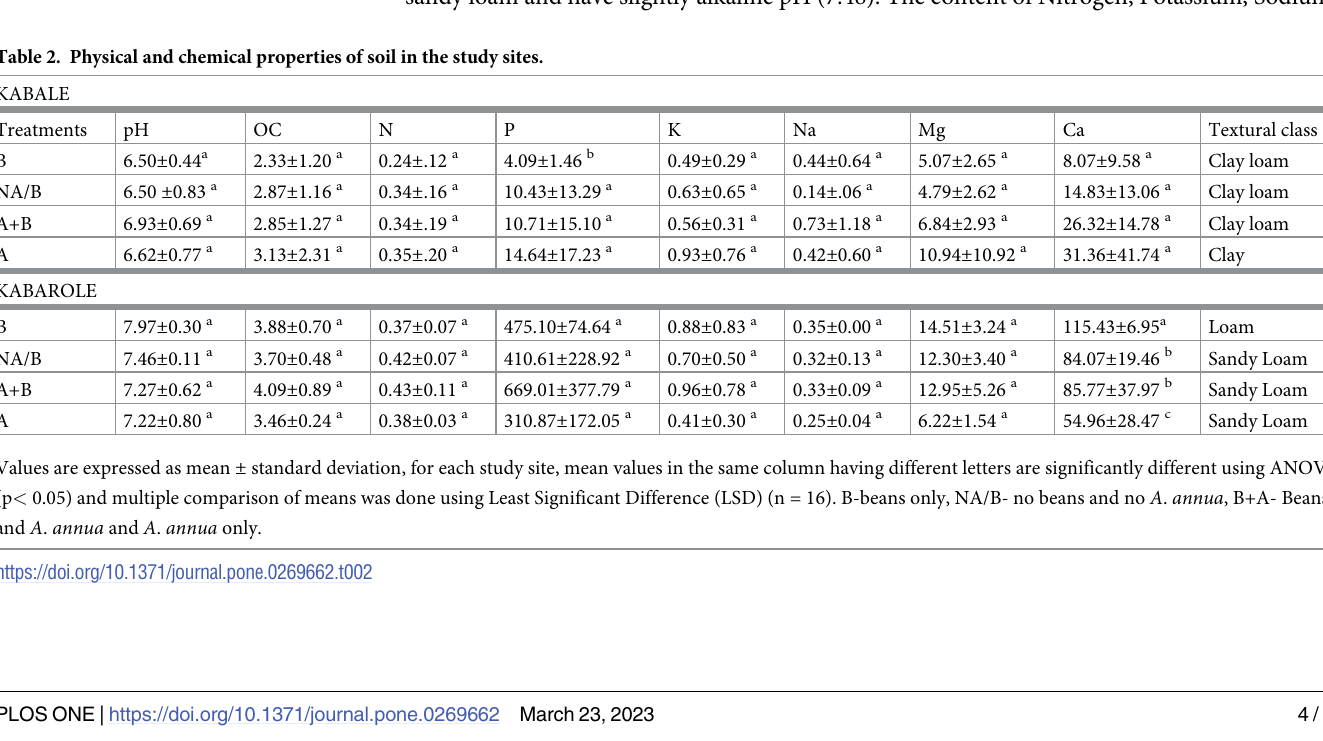
Table 2. Physical and chemical properties of soil in the study sites.